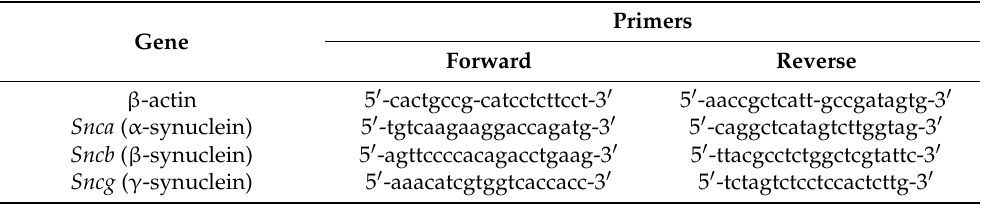
Table 1. Oligonucleotide sequences for primers used in the qRT-PCR.